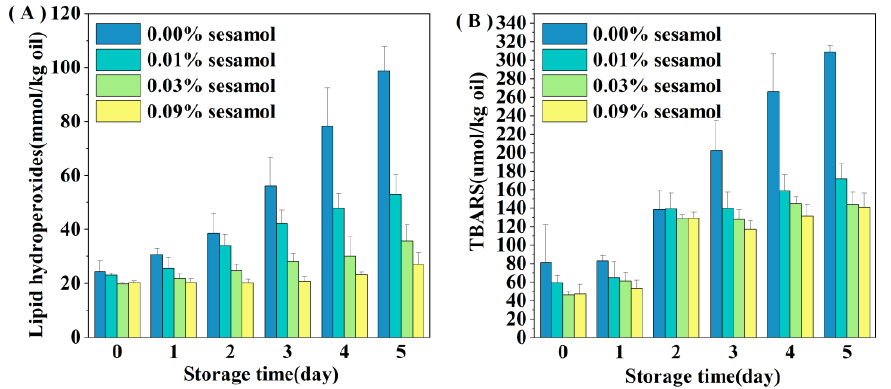
Figure 3. Effect of sesamol on lipid hydrogen peroxide ( A ) and TBARS ( B ) concentrations in WPI- stabilized fish oil emulsions during storage (30 mL of emulsion in a 50 mL glass bottle with screw cap stored at room temperature and protected from light).